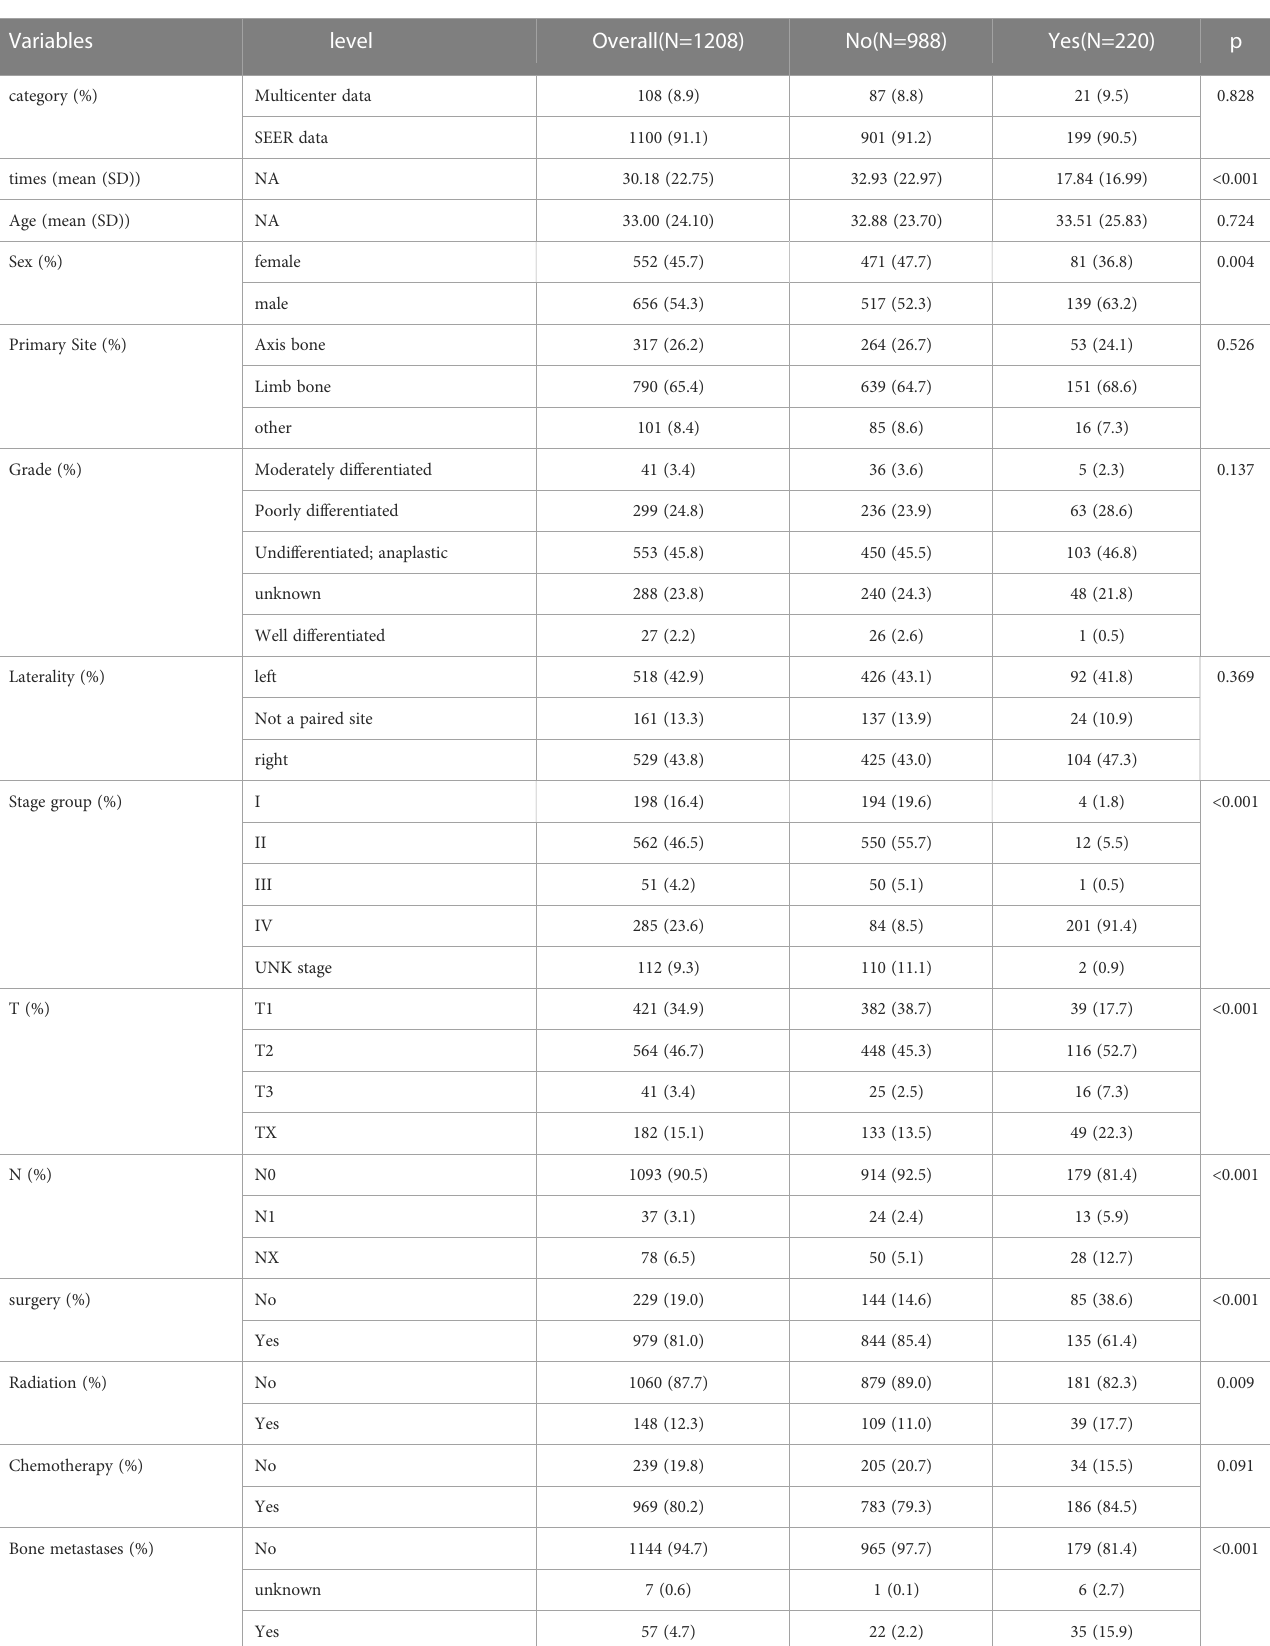
TABLE 2 Baseline data for patients presenting with and without lung